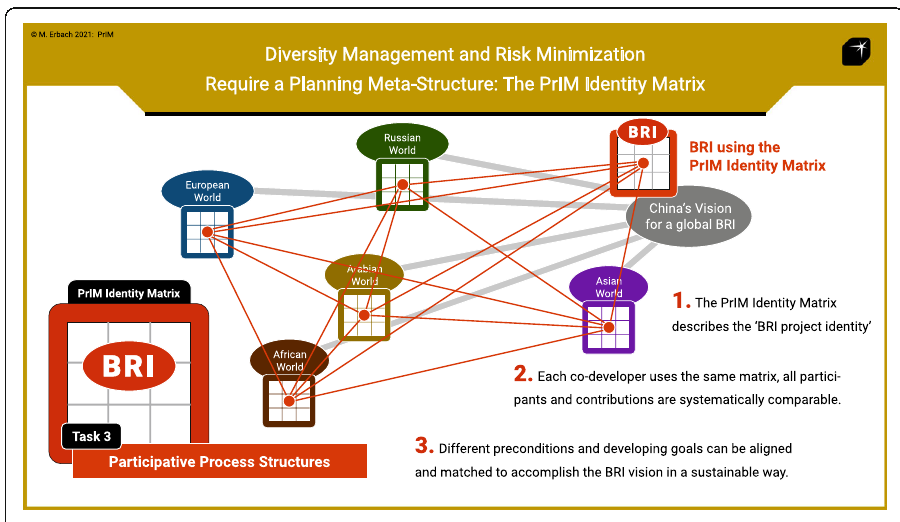
Fig. 5 The PrIM Identity Matrix as planning